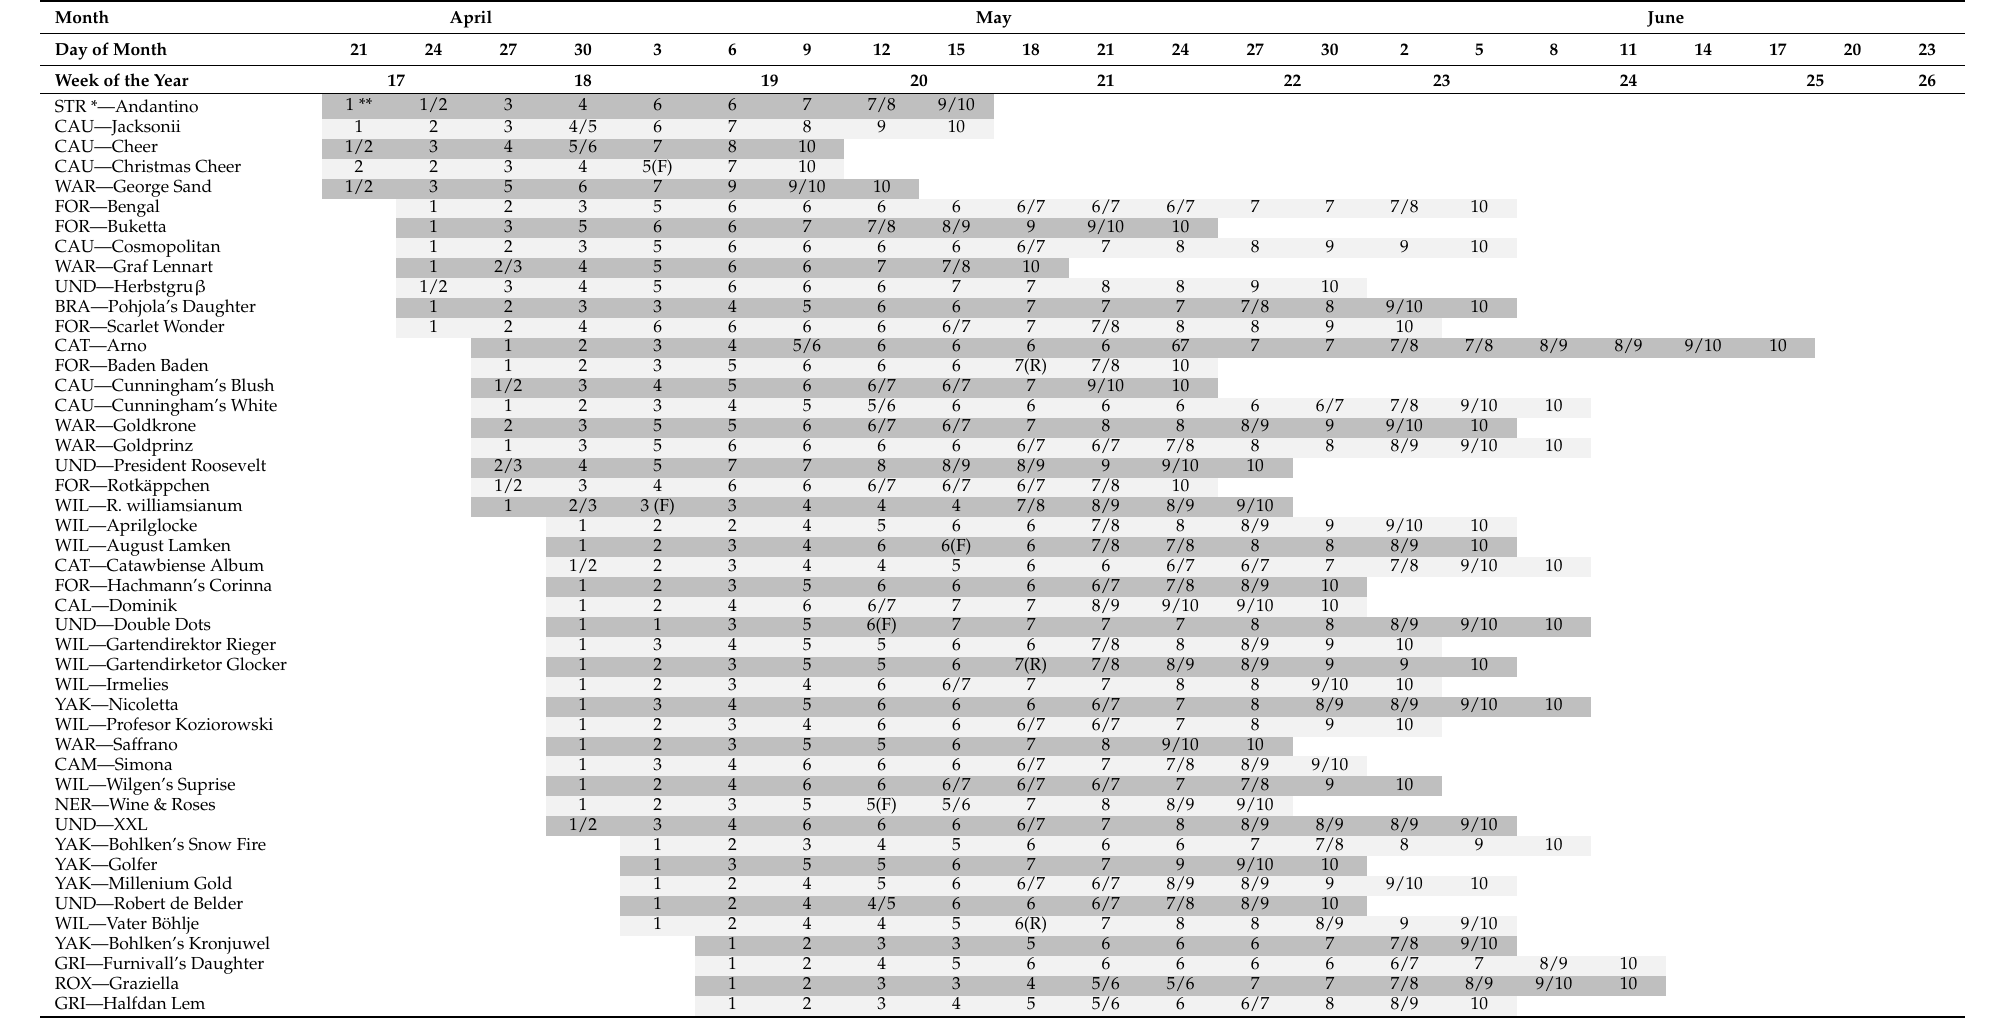
Table 3. Flowering phenology of selected 95 Rhododendron